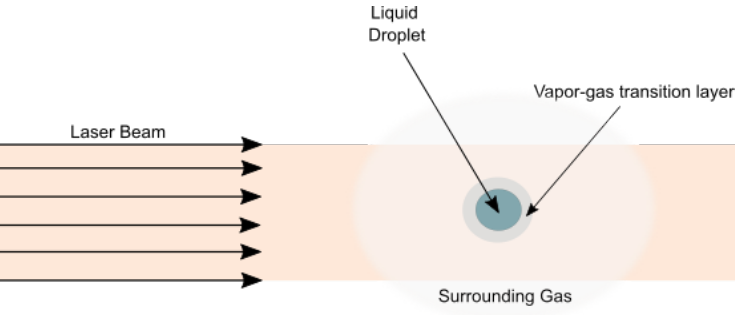
Figure 1. Schematic of laser heating of a droplet in ambient gas (not to